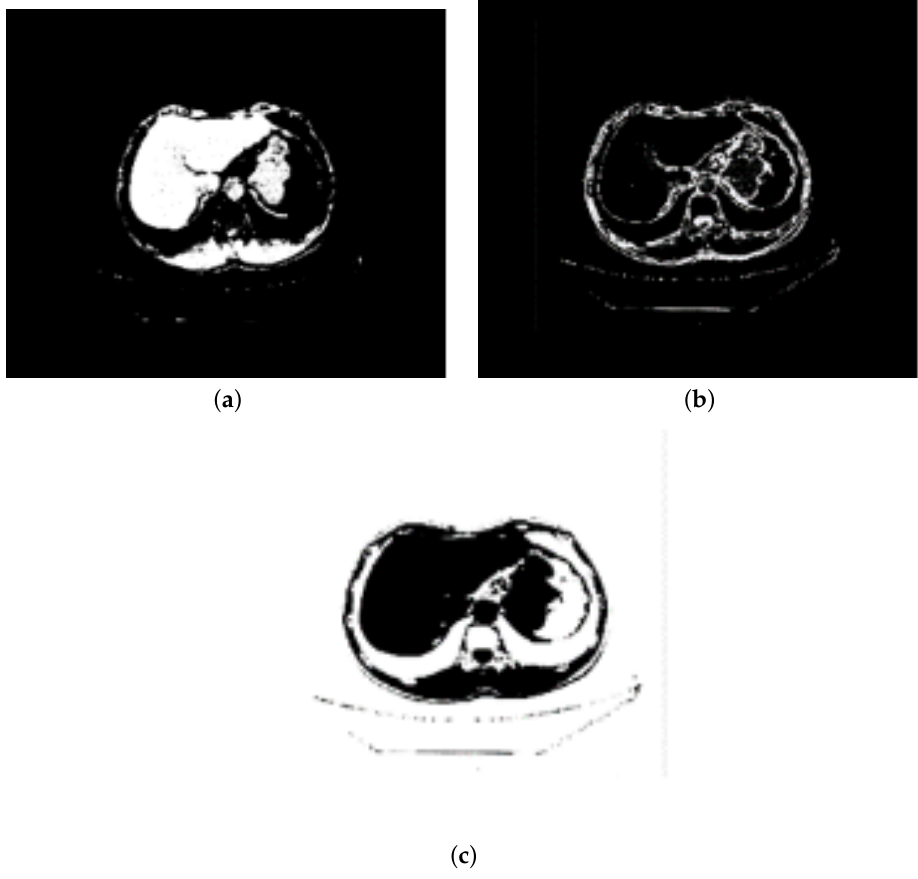
Figure 3. SFCM clustering: ( a – c ) show the results after SFCM clustering.